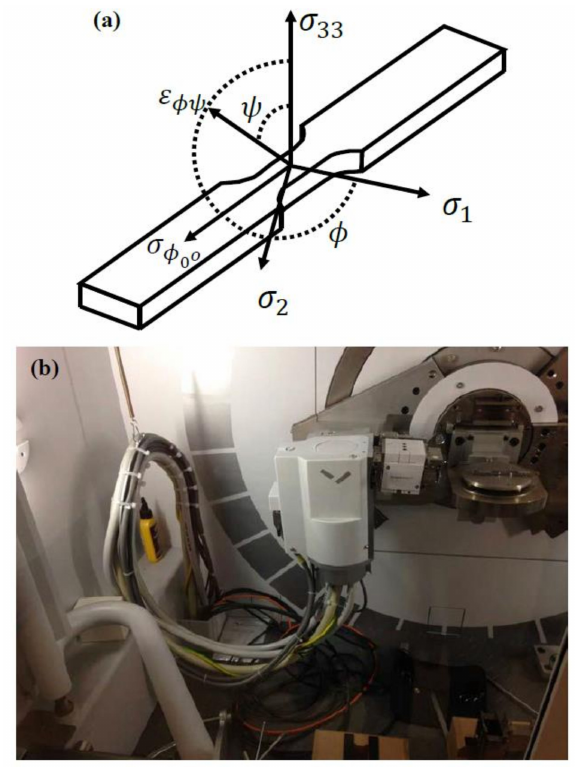
Figure 6. XRD System. ( a ) Drawing of di ff raction directions along the surface and at angles φ and ψ . Both σ 1 and σ 2 are perpendicular and reside in the plane of the specimen surface; ( b ) sample oriented at 0 ◦ on multi-purpose stage of Emperyean